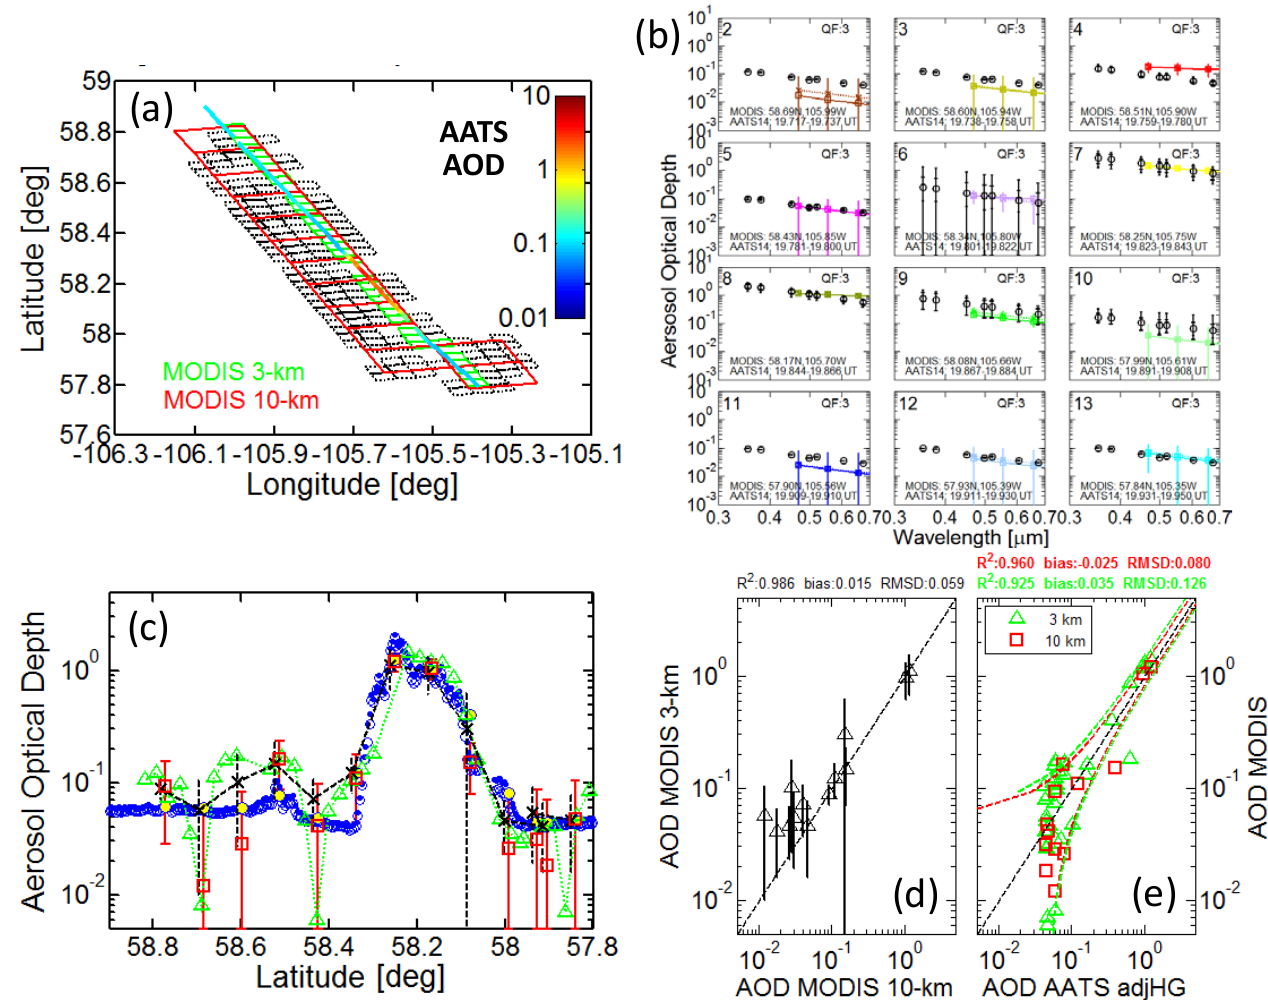
Fig. 3. Results for 30 June 2008 AATS–MODIS coincidence. (a) Plan view map showing overlay of P-3 flight track (color-coded by AATS 520nm AOD), MODIS operational 10km and 3km retrieval grid cells intersecting the P-3 track, and MODIS 3km (black) grid cells intersecting the 10km grid cells. (b) MODIS (colored symbols and lines follow same color scheme as in Fig. 1b) and unadjusted AATS (black circles) AOD spectra within the 10km grid cells. Cell number is given in the upper left of each panel, and the MODIS retrieval quality flag QF is listed in the upper right. The northernmost cell, cell 1, has been omitted to maximize the display. Vertical bars on the AATS AOD points represent ± 1 sample standard deviation (wide ticks) and range (narrow ticks) of AOD within each cell. MODIS AOD spectra are shown for the operational retrieval (colored squares with solid line) and for the retrieval with the aerosol cloud mask and the NDVI mask off (colored cross symbols with dashed line). (c) Latitudinal variation of 553nm AOD for AATS (blue circles before and blue dots after addition of below-aircraft AOD estimate), for MODIS 10km (red) and 3km (green) operational retrievals along the P-3 track, and for mean ± 1 standard deviation MODIS 3km retrievals (black) within each 10km cell. (d, e) Scatterplots of the data shown in (c) . Dashed lines in (e) represent the one-to-one MODIS/adjusted AATS AOD correspondence, and ± 1 standard deviation boundaries of the MODIS AOD expected errors (EE, defined in text). The AATS values in (e) include below-aircraft AOD estimated from the HiGEAR data.